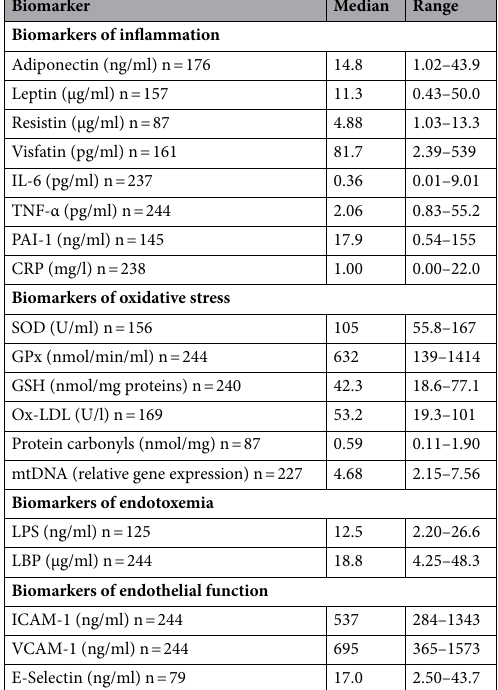
Table 2. Median and range values of each blood biomarkers according to their functional group. CRP: C-reactive protein; GPx glutathione peroxidase; GSH: glutathione; ICAM-1: intercellular adhesion molecule-1; mtDNA: mitochondrial DNA; LBP: lipopolysaccharide-binding protein; LPS: lipopolysaccharide; Ox-LDL: oxidized-low-density lipoprotein; PAI-1: plasminogen activator inhibitor-1; SOD: superoxide dismutase; TNF- α: tumor necrosis factor-α; VCAM-1: vascular cell adhesion